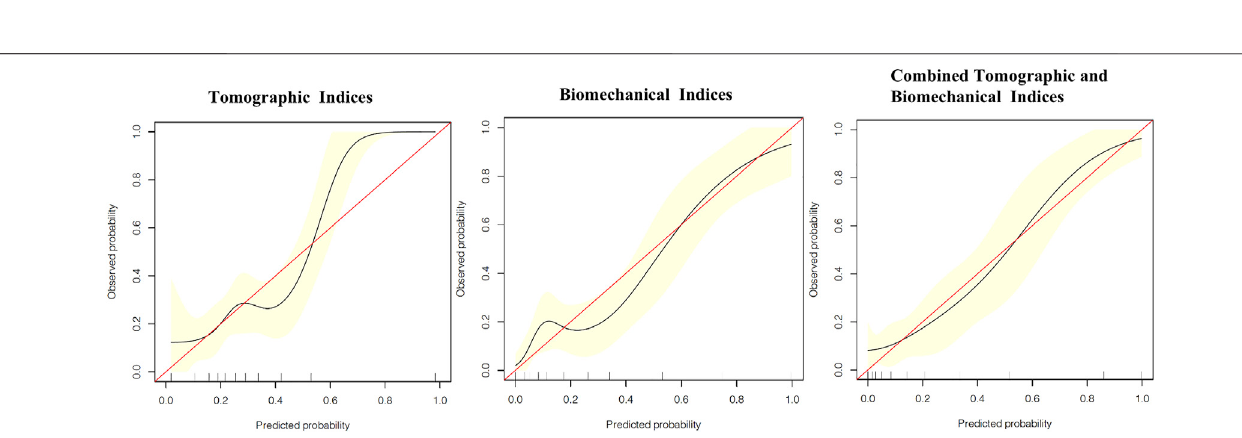
Frontiers in Bioengineering and Biotechnology |